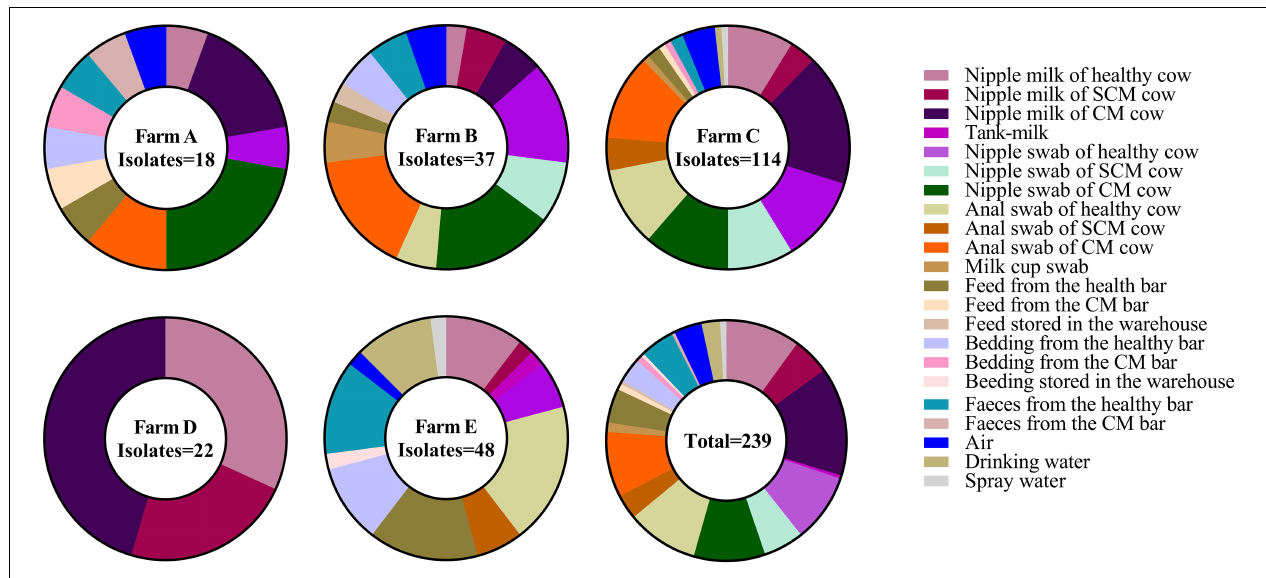
FIGURE 1 | The percentage of Klebsiella pneumoniae ( K. pneumoniae ) in different sample types in five